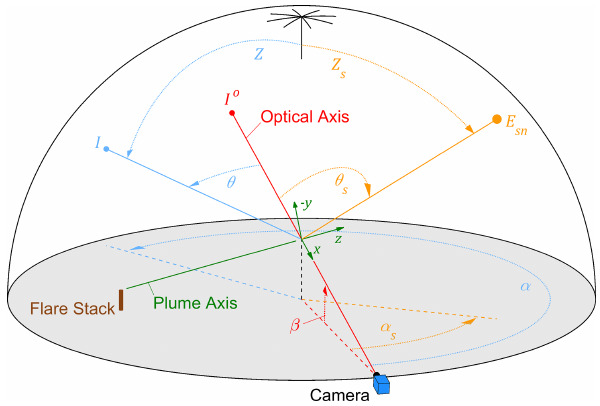
Figure 2. Schematic of a sky-LOSA measurement under the hemi- spherical sky dome showing the camera’s optical axis relative to the horizon ( β ), sun ( α s , θ s , and Z s ), and example sky element ( α , θ , Z ) (adapted from Conrad et al.,